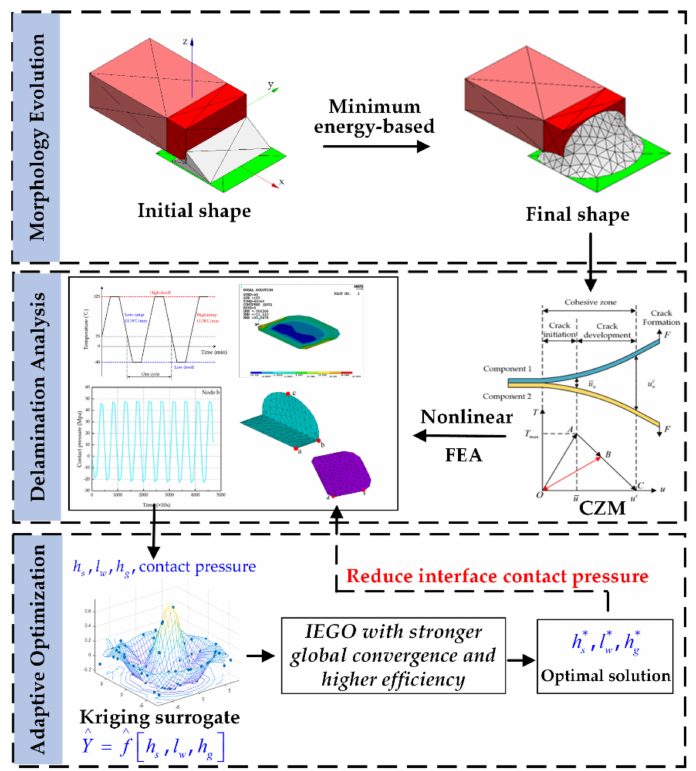
Figure 2. The framework of this